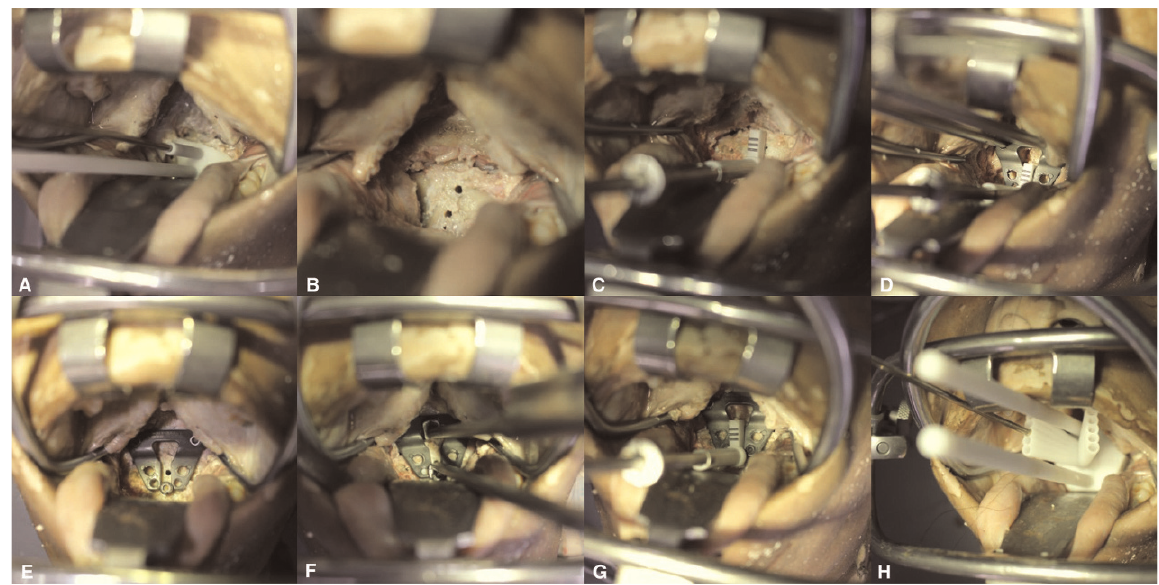
Figure 8 - A diagram showing the operative process with the templates. A The positioning of Template A on the C2 anterior surface and the bone drilling guided by it. B The drilled bone holes. C The positioning of Template B on the anterior surface of C2. D The positioning of the TARP-IV according to the location of the cubic module of Template B. E The relationship between the TARP-IV and the reduction screw head after it is fastened on C1. F Reduction process. G Measurement with Template B after the preliminary fixation of the TARP-IV on C2. H Template C-guided screw trajectory drilling. (The drilling was performed through the central ideal drill guide because the measurement showed that the centers of the screw holes in TARP-IV were aligned with the central ideal level of Template B in Figure 8G ).